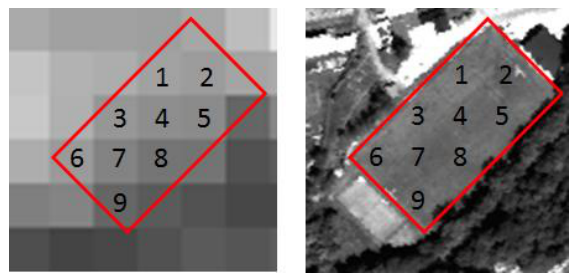
Figure 2. Scheme of collect spectra. Test site 1 from Resurs-P (left) and CASI (right)